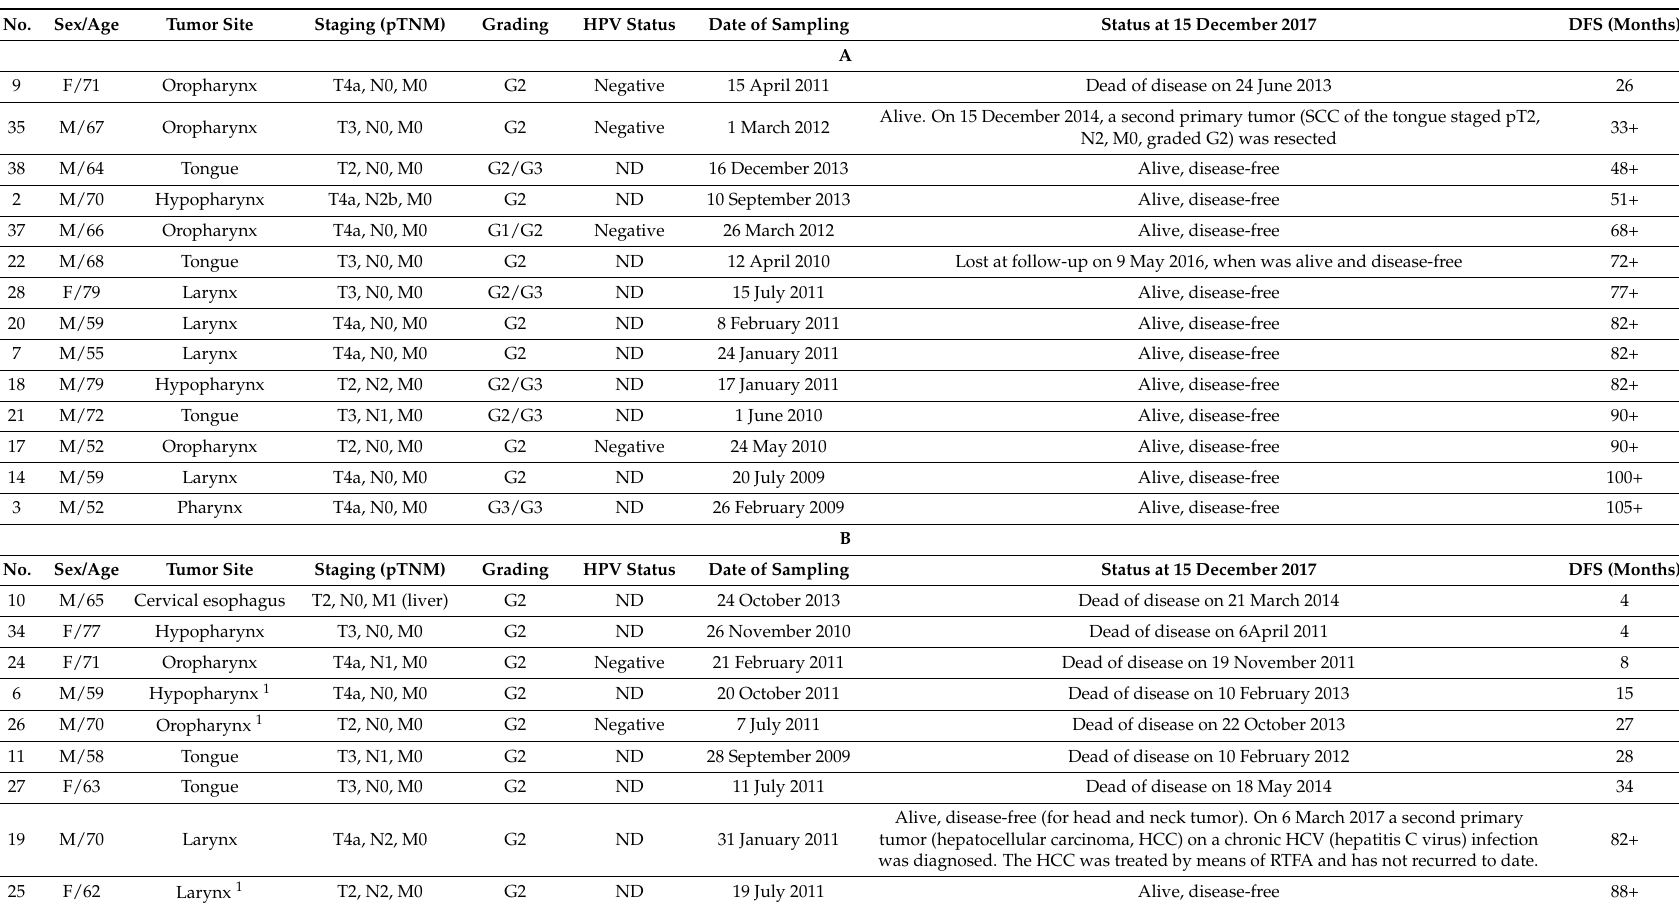
Table 1. Clinical and histopathological data of the patients analyzed in this study. (A) Higher or similar expression of TERRA in tumor compared to normal tissue ( n = 14); (B) Lower expression of TERRA in tumor compared to normal tissue ( n =